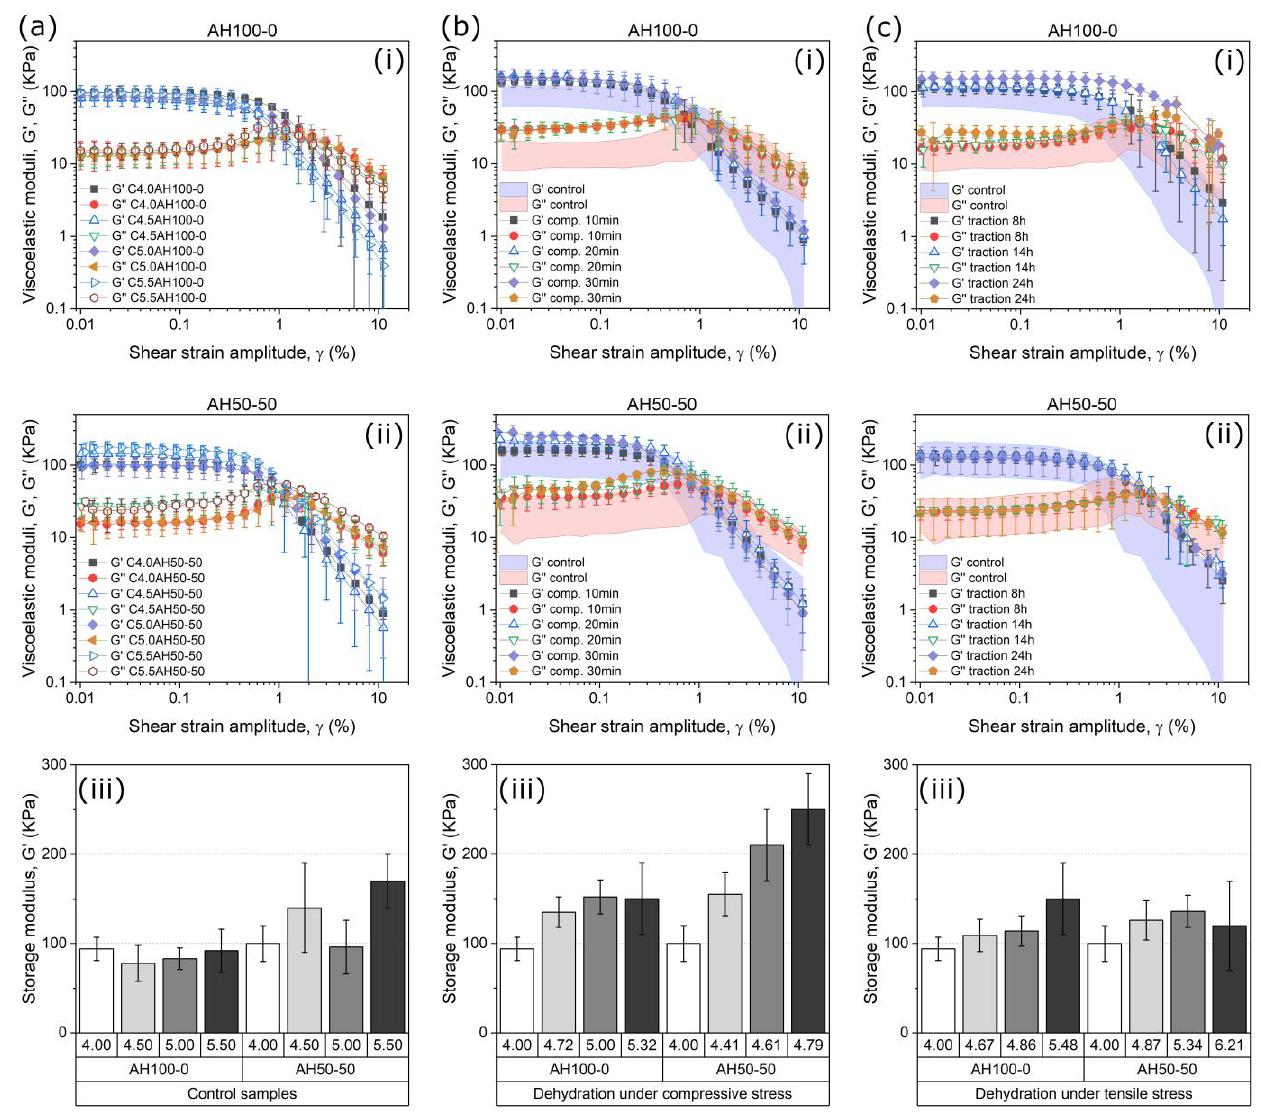
Figure 2. Results from the rheological characterization under oscillatory shear. The data in each column is related to the stress applied during the dehydration, ( a ) control samples, ( b ) samples dehydrated under compressive stress and ( c ) samples dehydrated under tensile stress. The data in the first two rows are presented as a comparison between the curves obtained for ( i ) AH100-0 and ( ii ) AH50-50, and in the third row ( iii ) the values of the storage modulus G ′ obtained from the previous curves are shown. The areas in ( b (i)), ( b ( ii )), ( c ( i )) and ( c ( ii )) represent the ranges of values for control samples. Note that same scales are used in both axes.